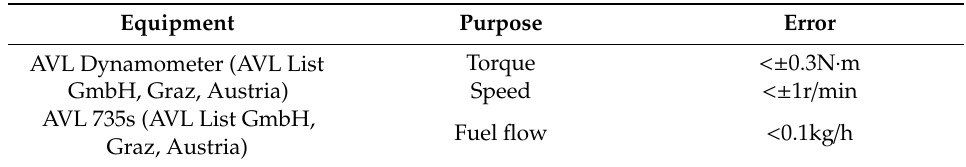
Table 2. Equipment of the test bench.